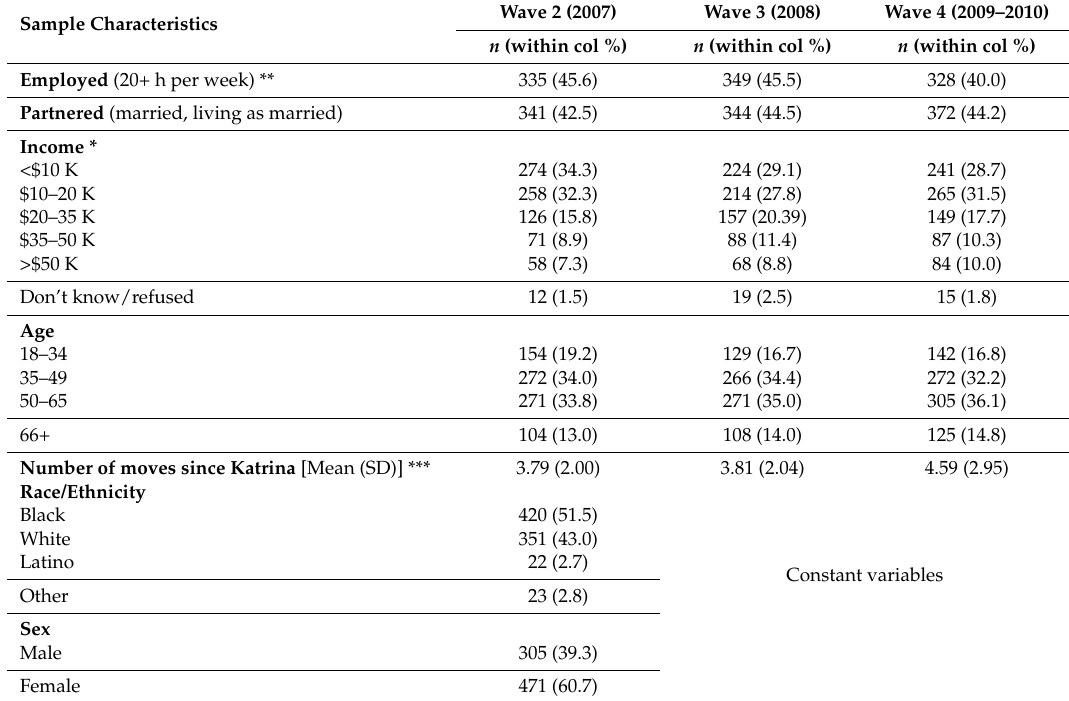
Table 1. Sample Characteristics and significance of change over